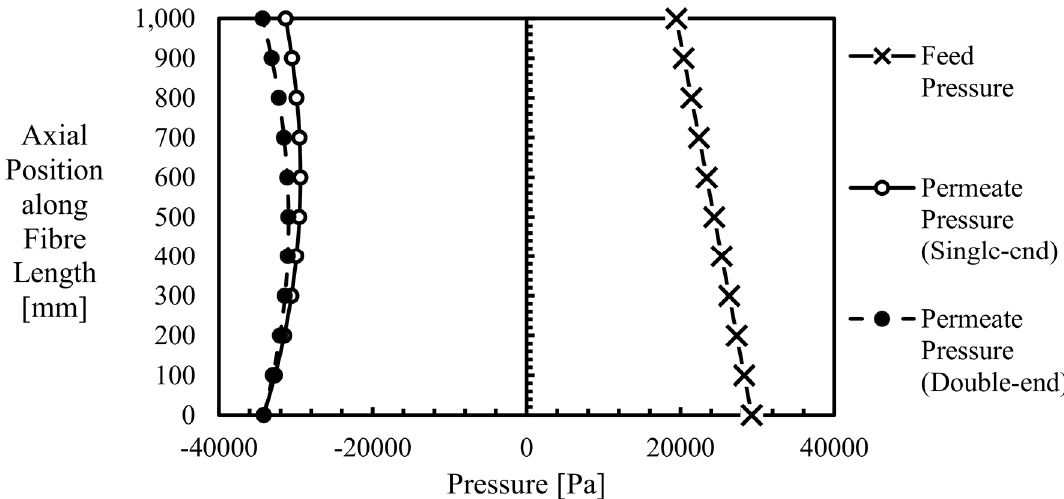
Figure 15. Feed and permeate pressure distribution of fibre with 0.5 mm inner diameter, 0.3 membrane thickness, and membrane permeability of 1.01 × 10 − 16 m 2 (100 LMH/bar), in single-end and double-end suction. λ value of this fibre was calculated to be 0.87 m − 1 .